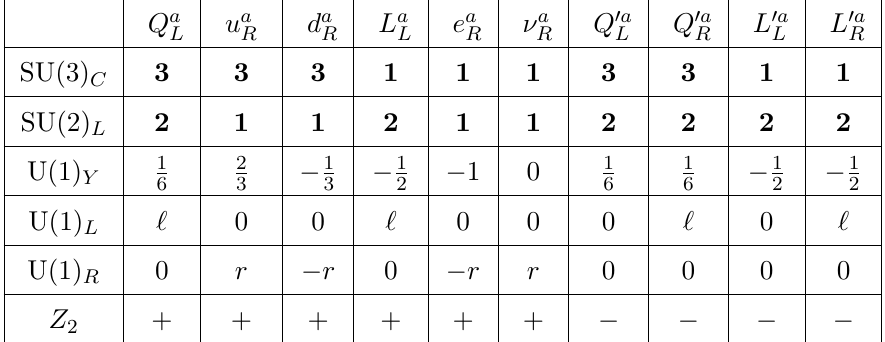
(cid:2) U(1) but R Y R